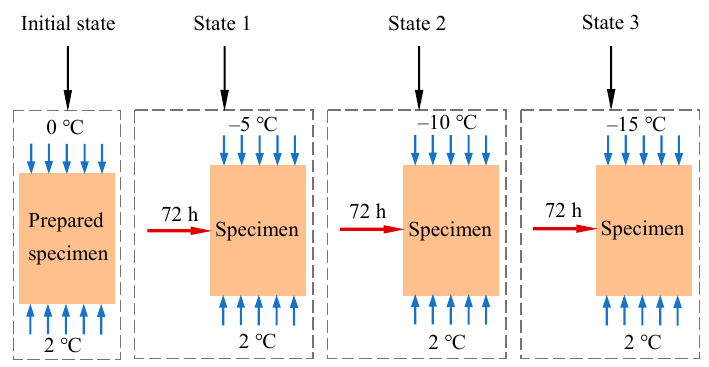
Figure 4. Temperature scheme for the freezing tests.